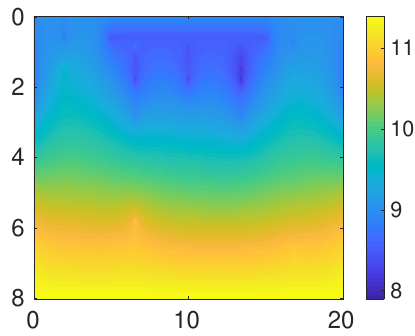
Figure A7. The initial heat distribution computed via Laplace interpolation using the initial tempera- ture given by temperature probes at time t = 0, see Section 2.4. The interpolation task is performed with suitable boundary